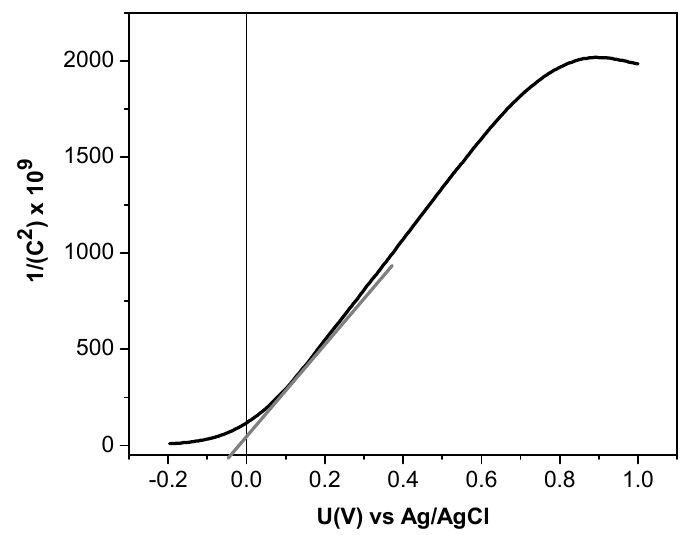
Figure 9. Mott–Schottky plot of maghemite nanoparticles.